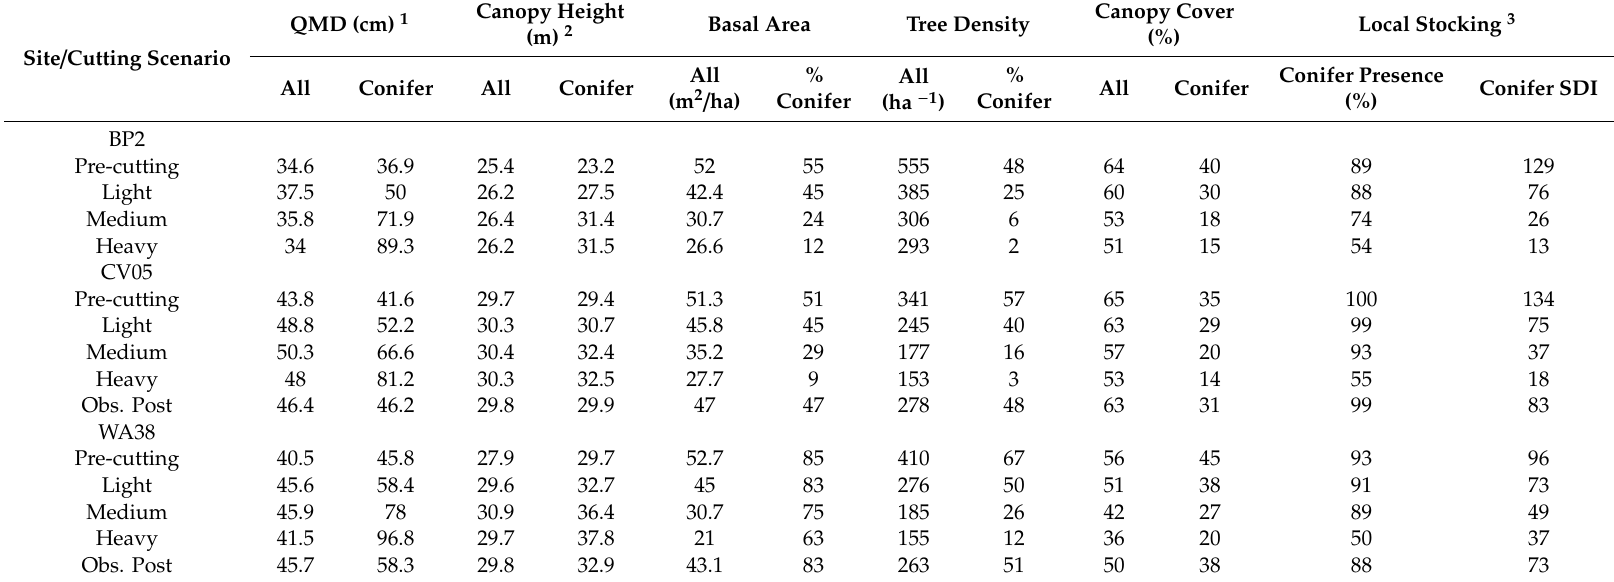
Table 2. Summary of forest structure and local stocking proximate to aspen pre-cutting; after simulated light (removal of conifers < 36 cm dbh), medium (removal of conifers < 56 cm dbh), and heavy (removal of conifers < 76 cm dbh) cuttings; and in the observed post-treatment cutting. QMD and SDI are quadratic mean diameter and stand density index,